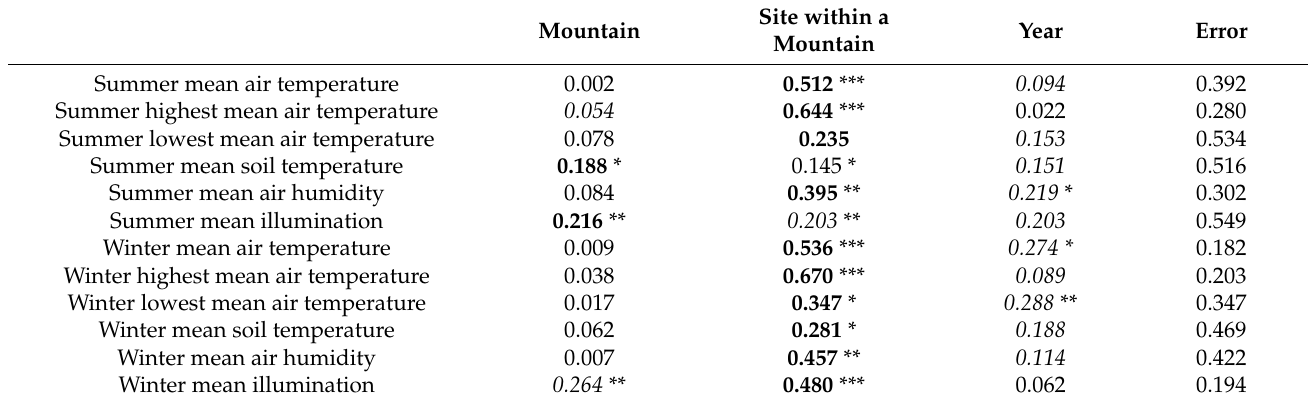
Table 1. Variation partitioning of environmental factors among explanatory variables.